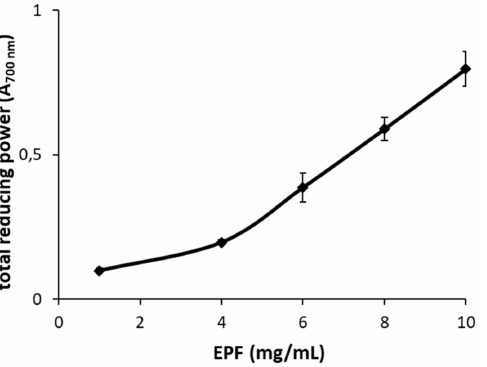
Figure 3. Total reducing power of the enriched polysaccharide fraction (EPF) from P. eryngii. Results are expressed as absorbance at 700 nm. Data are mean values ± SD of n = 3 experiments performed on different